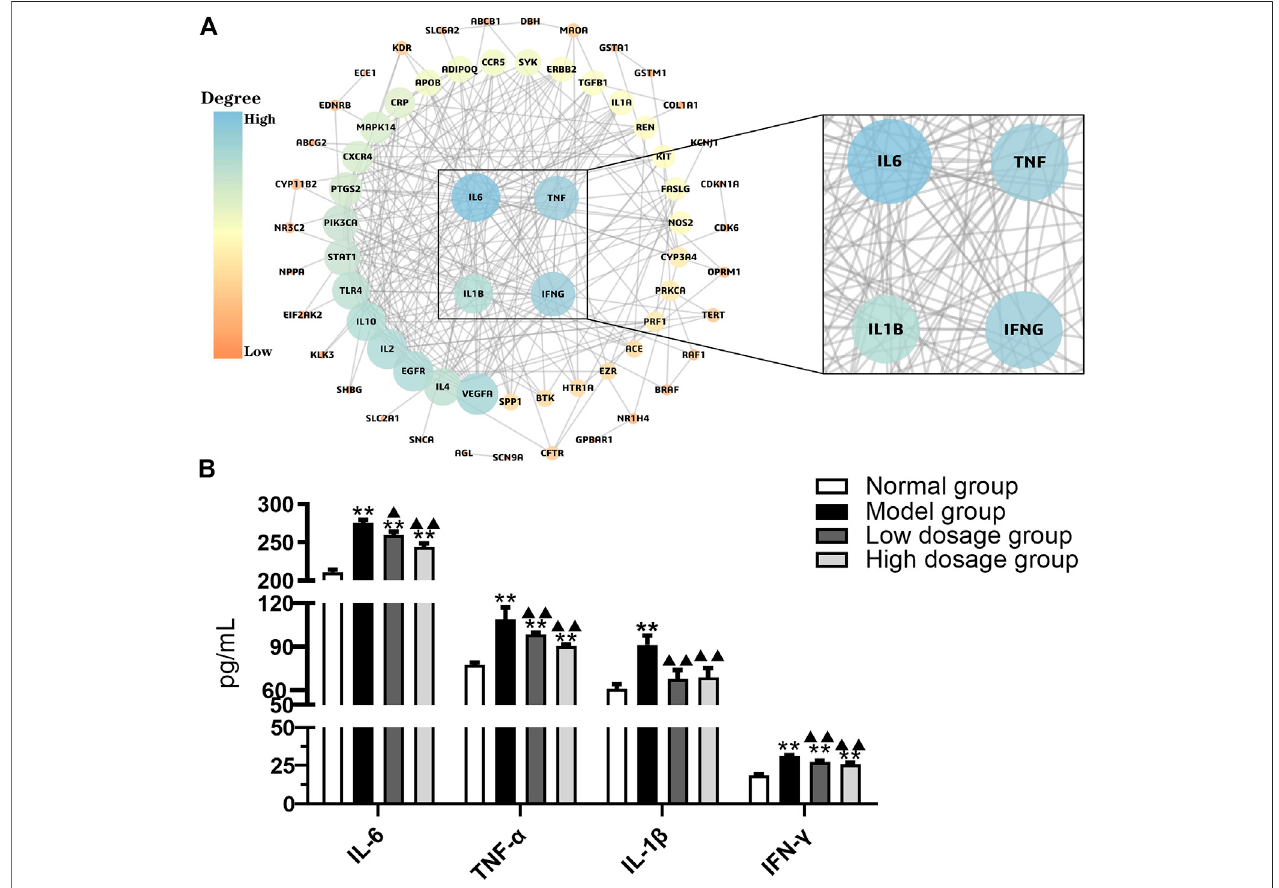
FIGURE 2 | PPI network (A) and the level changes of IL-6, TNF- α , IL-1 β , and IFN- γ (B) . * p < 0.05 and ** p < 0.01 vs. normal group. ▲ p < 0.05 and ▲▲ p < 0.01 vs. model group.